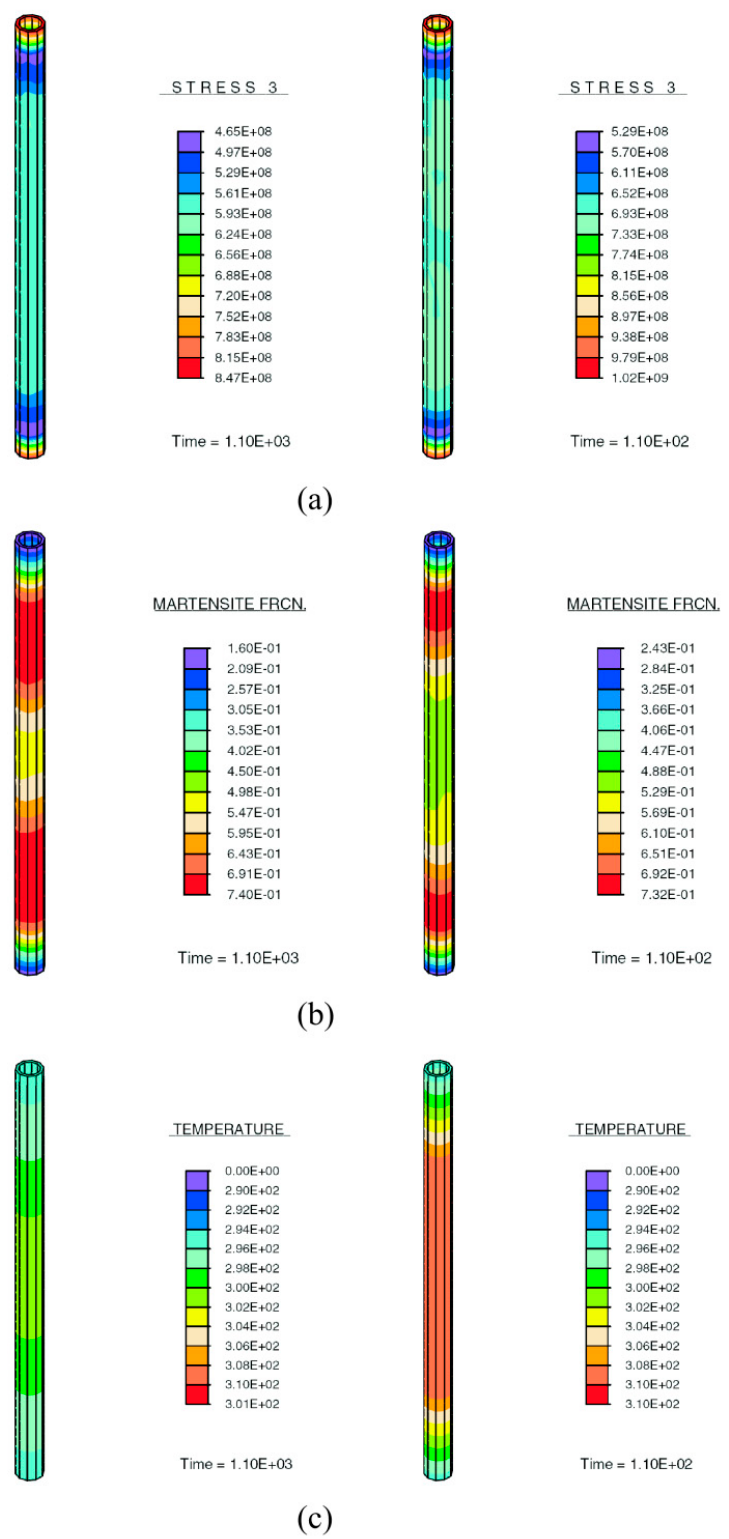
Figure 15. Macroscopic results of Nitinol tube under stretch (taken with permission from [102]). ( a ) Longitudinal Cauchy’s stress (Pa); ( b ) martensite fraction; and ( c ) temperature [K]. Left and right results for an imposed strain rate of 10 − 4 s − 1 and 10 − 3 s − 1 , respectively.